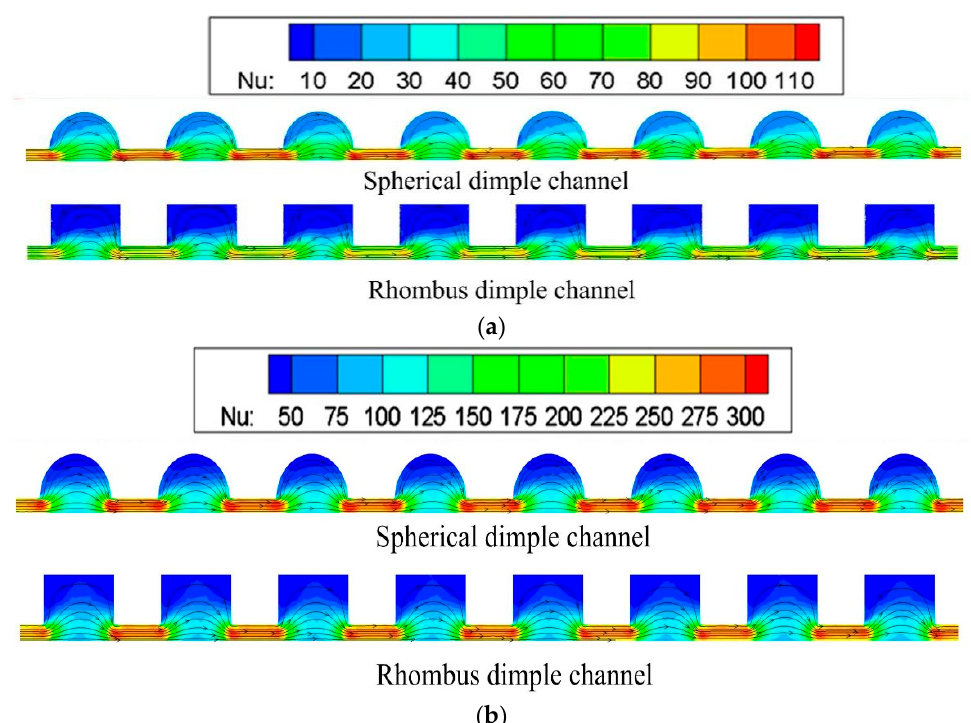
Figure 12. Nusselt numbers on the dimpled surfaces under different Reynolds numbers. ( a ) Re =3000. ( b ) Re =20,000. different dimpled channels. The Nusselt number of fluid flow in the hemispherical dimpled